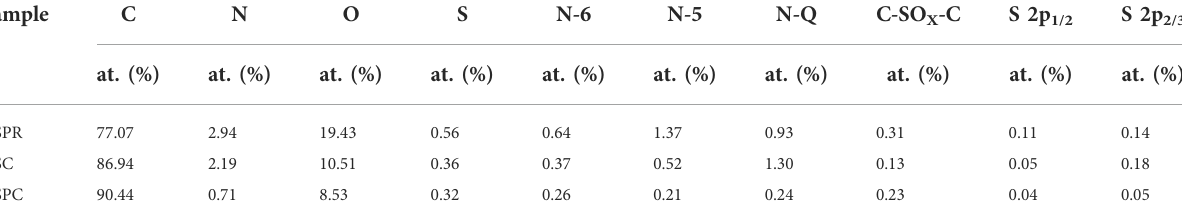
TABLE 2 Surface element composition determined by XPS and relative contents of functional groups in N 1s and S 2p peaks of samples.